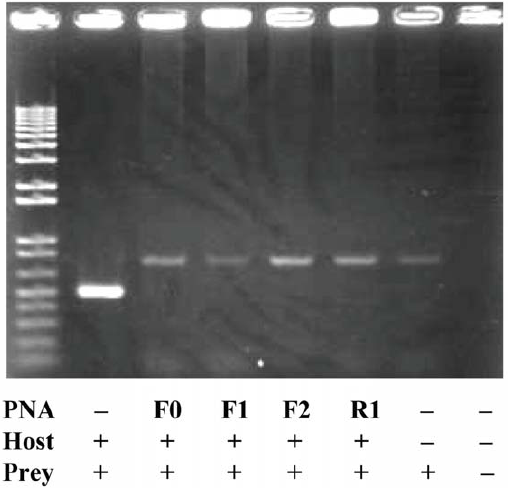
Figure 3. A result of PNA-directed PCR clamping using a mixed DNA template from a common type clone (eel00-01) and spiny lobster. Without PNA probe, eel ITS1 (c.a. 500 bp) was predominately amplified but lobster ITS1 was not (2 nd lane from the left). All PNA probes successfully inhibited amplification of eel ITS1 but did not inhibit amplification of lobster ITS1 (c.a. 680 bp; 3 rd to 6 th lane from the left).